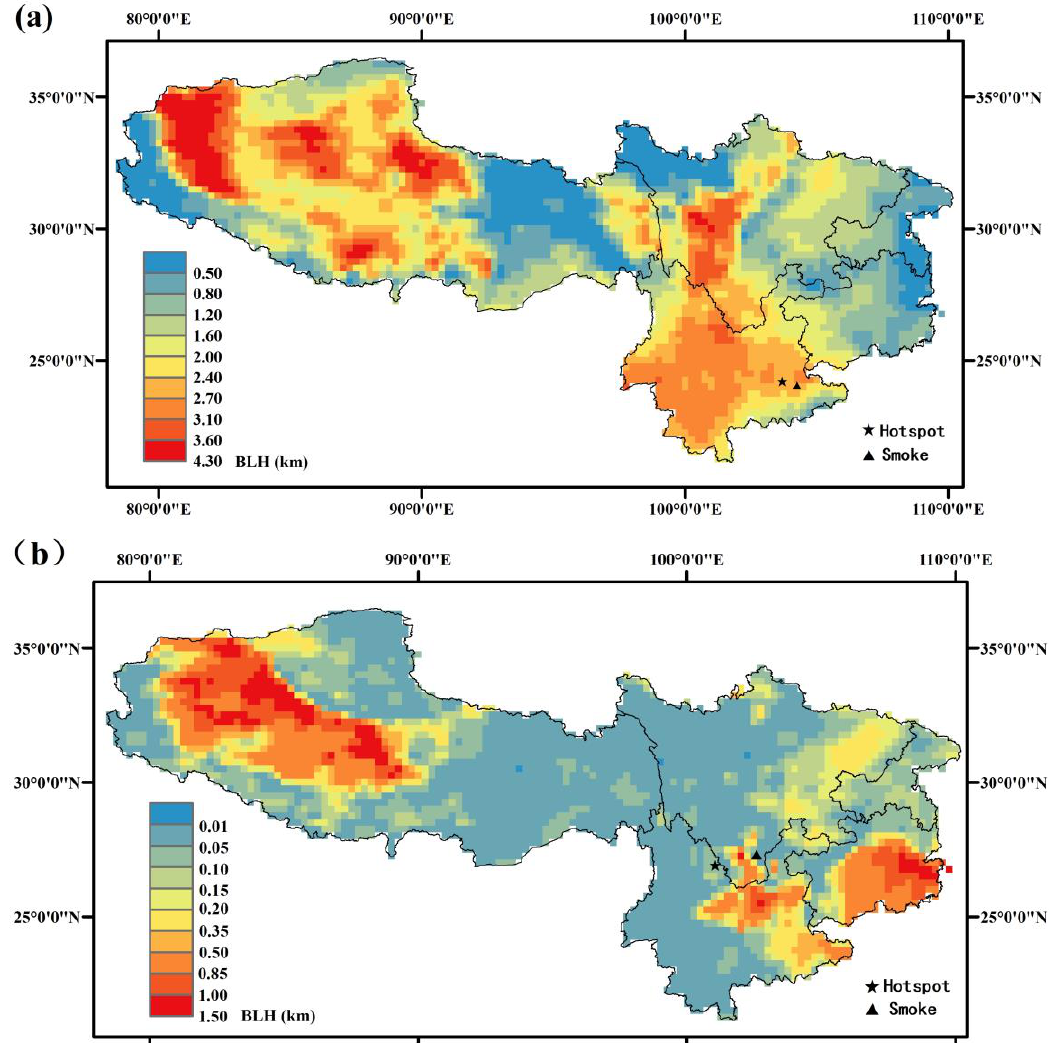
Figure 5. Distribution of the BLHs in Southwest China in ( a ) the afternoon (case 4) and ( b ) at night (case (case 5).